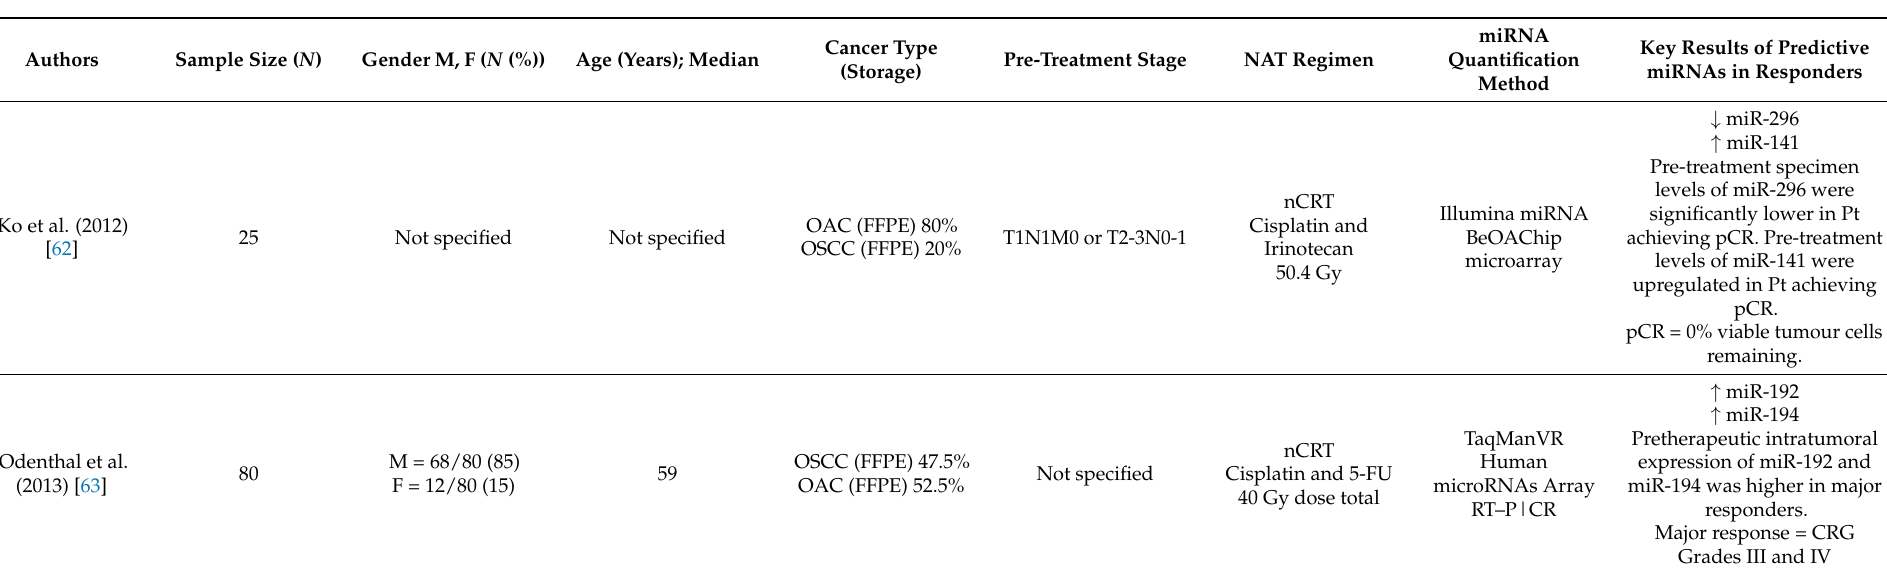
Table 3. Articles studying the utility of miRNAs in pre-treatment OAC and OSCC samples combined to predict response to